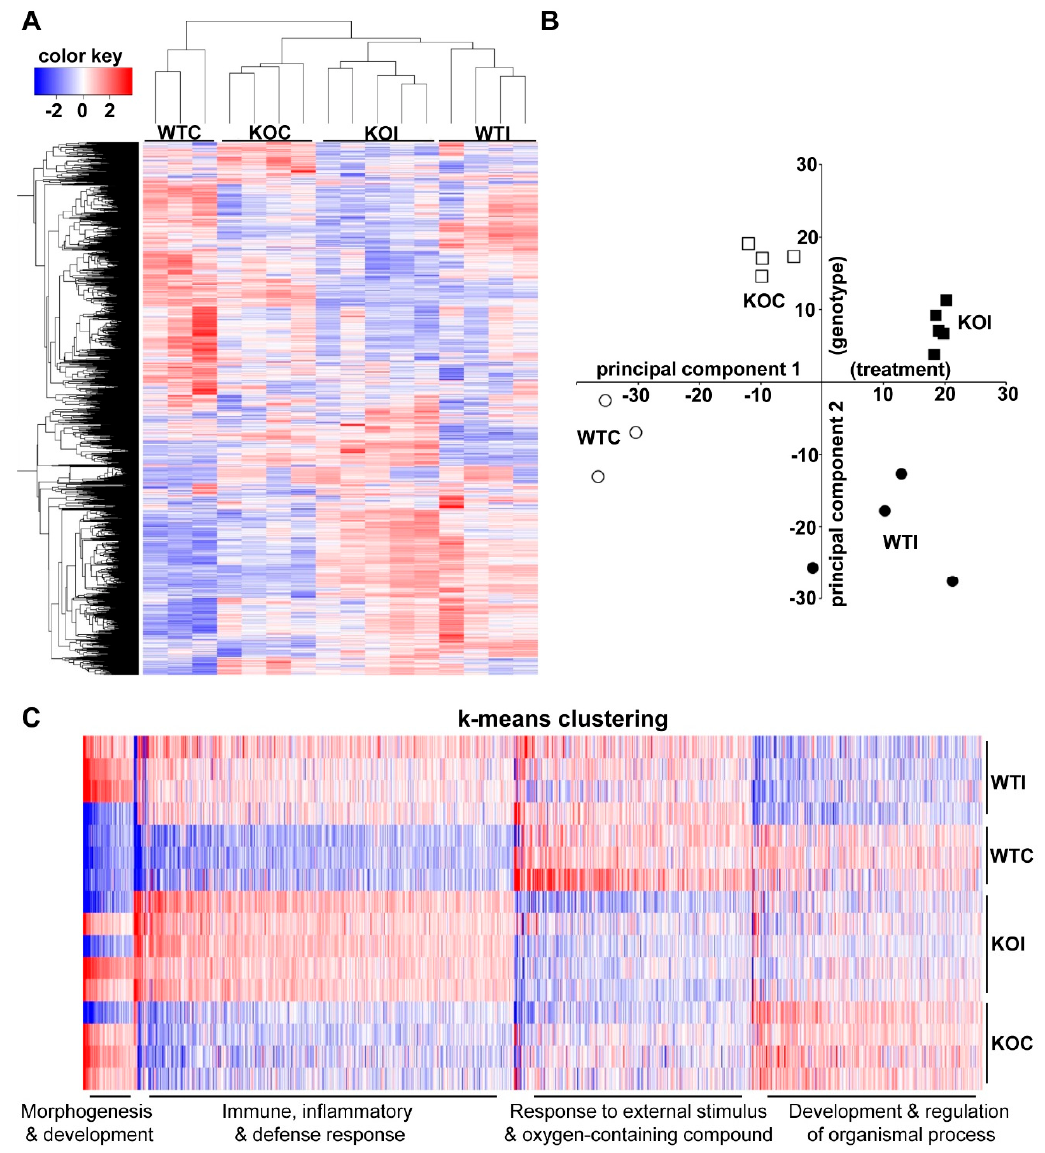
Figure 1. ( A ) Heatmap and clustering of the 1500 genes showing the most variable expression in the thyroids of the various cohorts of mice used for RNA sequencing (RNA-Seq). The heatmap was clustered by Euclidean distance and average linkage. Red color in the heatmap indicates higher expression and blue color indicates lower expression. ( B ) Principal component analysis (PCA) of RNA-Seq data. Of the total variance in gene expression, 29% can be attributed to PC1, which is correlated with treatment ( p = 1.14 × 10 − 4 ), and 16% can be attributed to PC2, which is correlated with genotype ( p = 3.74 × 10 − 5 ). ( C ) The 2000 most variable genes were clustered into groups using k-means clustering on the basis of their expression pattern across all samples followed by enrichment analysis for each cluster. The number of clusters was set to 4 following the “elbow method” (Figure S1B, Supplementary Materials). The enriched pathways for each cluster along with the p -values and genes in each pathway are shown in Table S1 (Supplementary Materials). Representative pathways for the largest clusters are indicated in the figure. Red color in the heatmap indicates higher expression while blue indicates lower expression. WTC: wild-type control mice (regular water); WTI: iodide-treated wild-type mice (0.05% NaI in water); KOC: nuclear erythroid factor 2 like 2 (Nrf2) knockout mice (regular water); KOI: iodide-treated Nrf2 knockout mice (0.05% NaI in water).